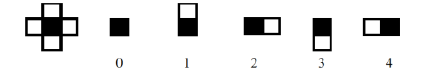
Figure 2. First-order neighbourhood system and its division into cliques. The black squares represent the site of interest and the white squares represent the neighboring